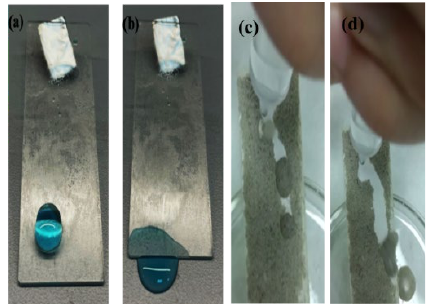
Figure 8. Optical images of the sliding water droplets ( a , b ) on the superhydrophobic surface and self-cleaning behavior of the superhydrophobic glass surfaces ( c , d ).